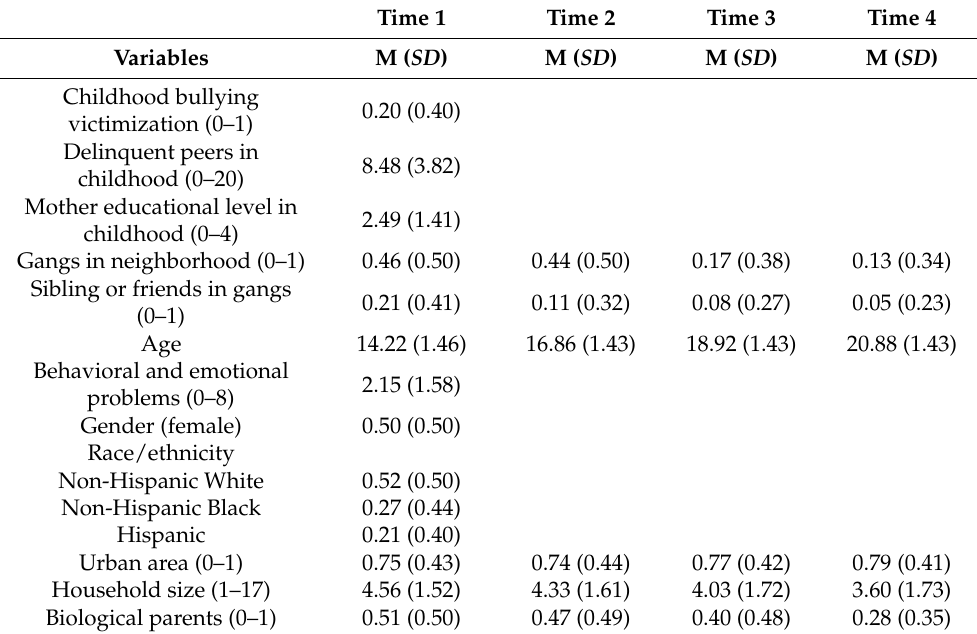
Table 1. Descriptive